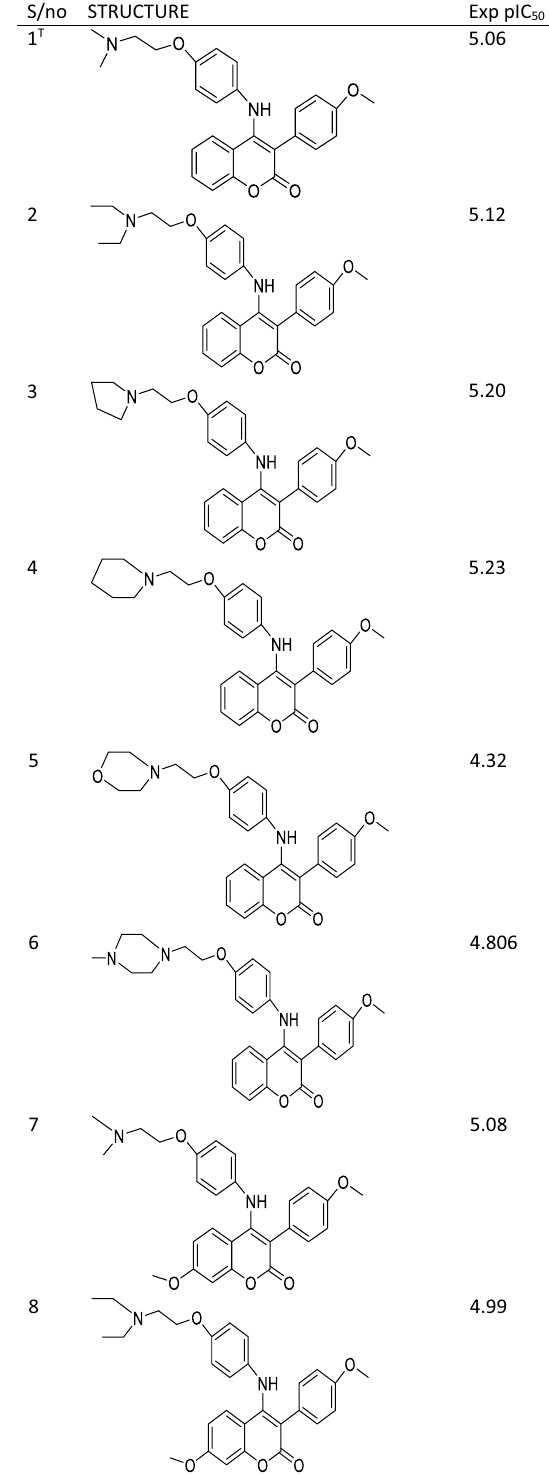
Table 1 2D structures of the Chromen-2-one derivatives